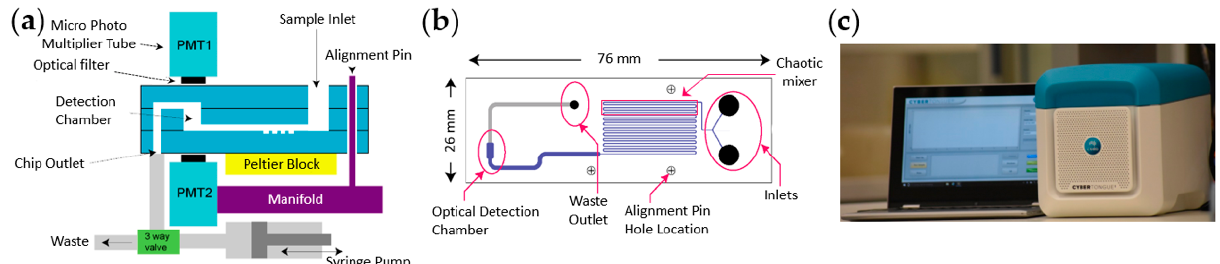
Figure 3. Overview of the Cybertongue ® BRET analysis device: ( a ) functional schematic of the measurement device, ( b ) schematic design of a microfluidic chip used for protease assays and ( c ) image of compact microfluidics device with closed lid. Figure was taken from Weihs et al. [48], with permission.